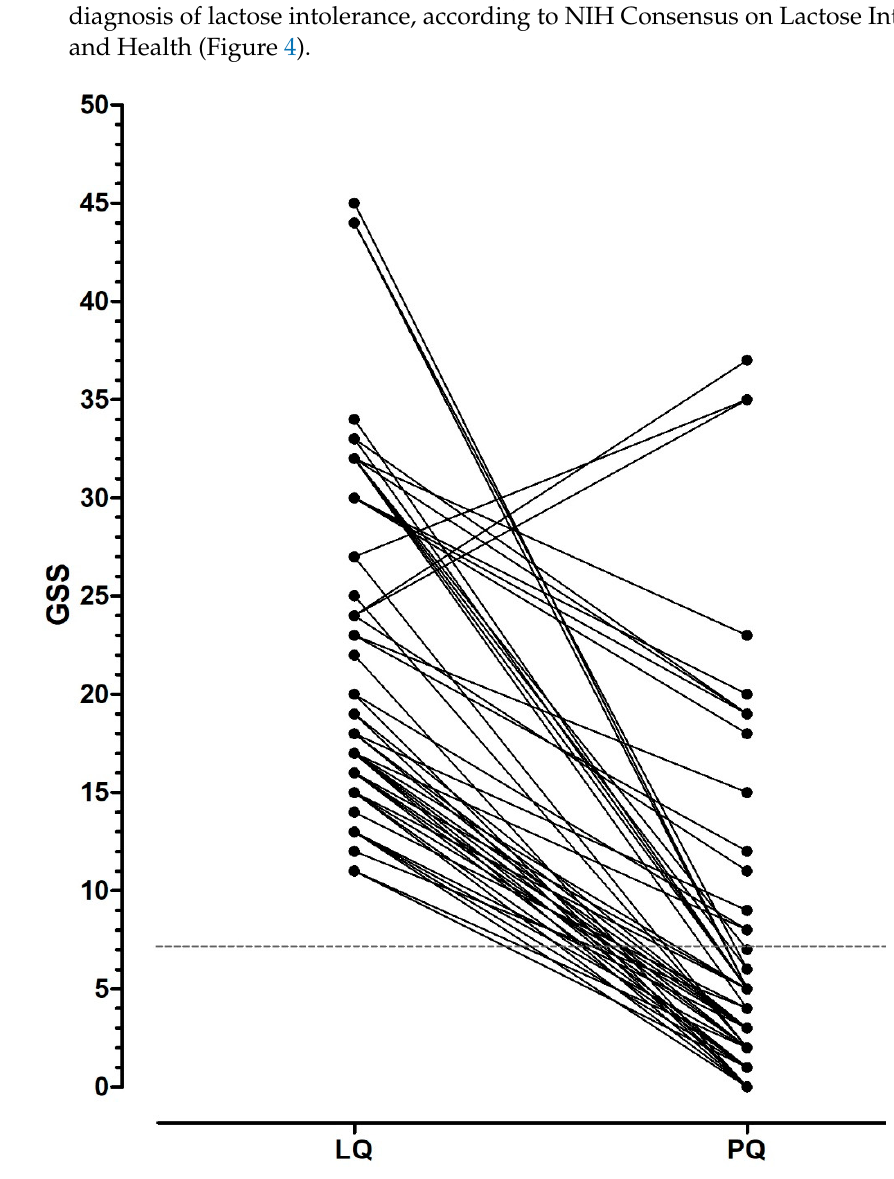
Figure 4. Global symptom score (GSS) after 25 g lactose load and placebo in the subgroup of patients classified as lactose malabsorbers according to lactose hydrogen breath test and abnormal symptom score after lactose load. Note that, after the placebo challenge, 15 patients still complain of clinically relevant symptoms. The dotted line indicates the cut-off value used to define the clinically relevant score of symptoms. LQ: lactose questionnaire, PQ: placebo questionnaire.